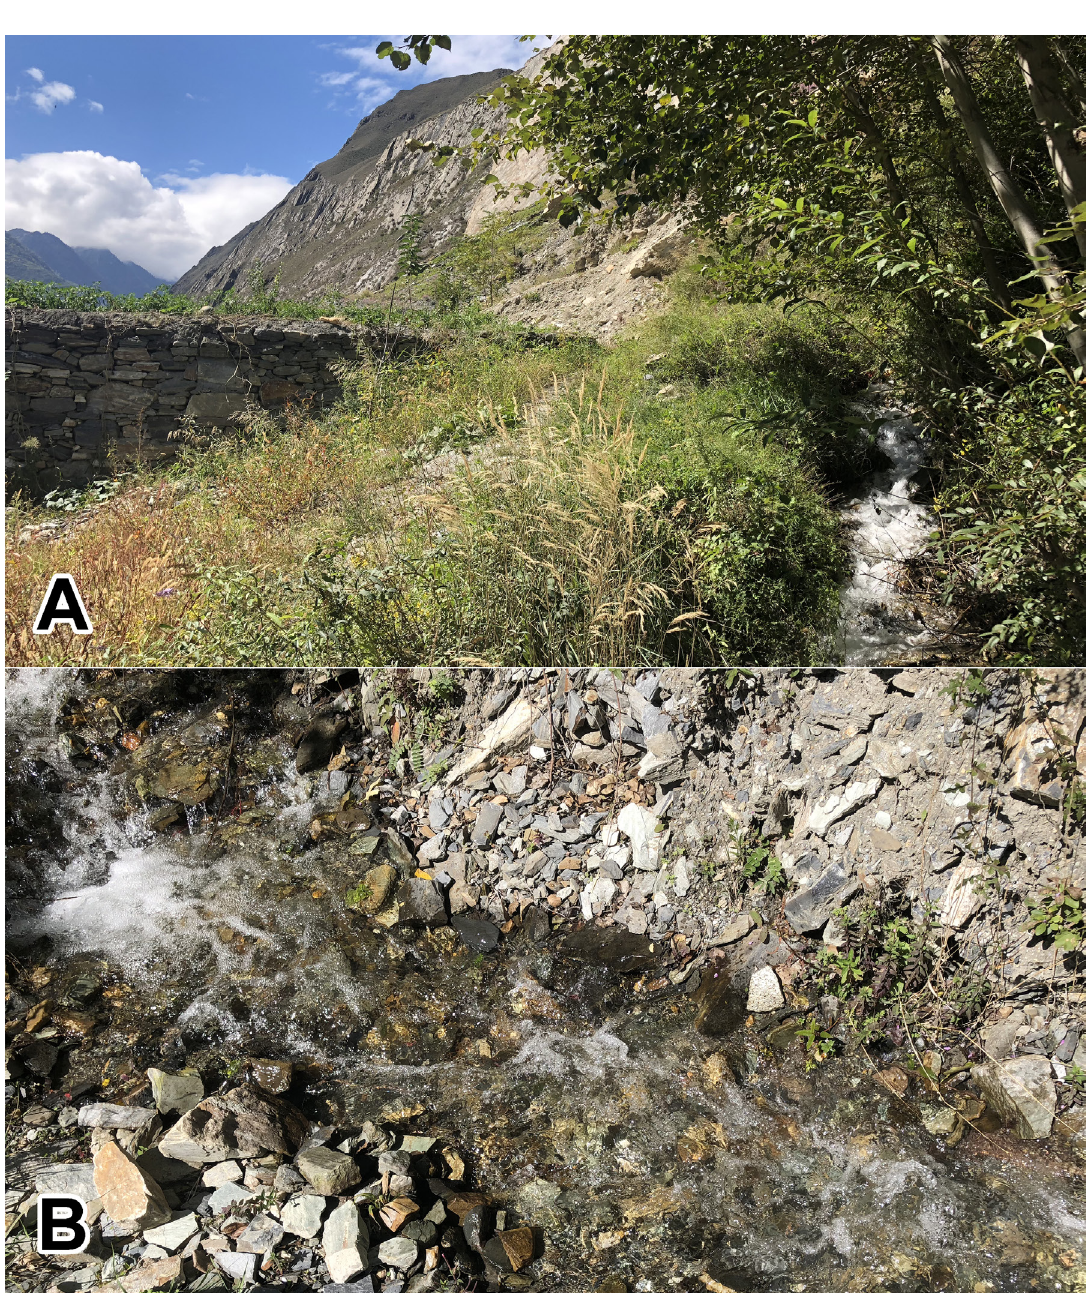
Fig. 7. Habitat of Nemoura lixiana sp. nov. in China, Sichuan Province. A . Unnamed stream flowing down from a mountain. B . Photo of the